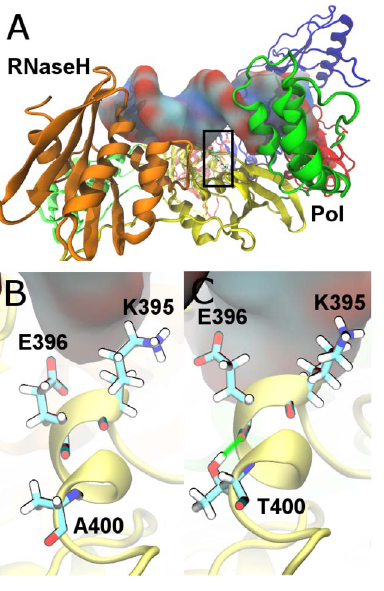
Figure 4. Structure of the HIV-1 reverse transcriptase (RT) enzyme. (A) Shows RT bound to a DNA/DNA template/primer complex (shown in surface representation). The enzyme is shown in cartoon representation and coloured by subdomain; fingers are blue, palm red, thumb green, connection yellow and the RNaseH orange. The p66 subunit is shown in the foreground and in darker shades. A black rectangle indicates the location of the p51 RNaseH primer grip. (B) and (C) show detailed views of this region, including chemical representa- tions of the residues K395 and E396 in the wild-type and A400T RT enzymes, respectively. A green line is used to illustrate the hydrogen bond formed between T400 and E396.